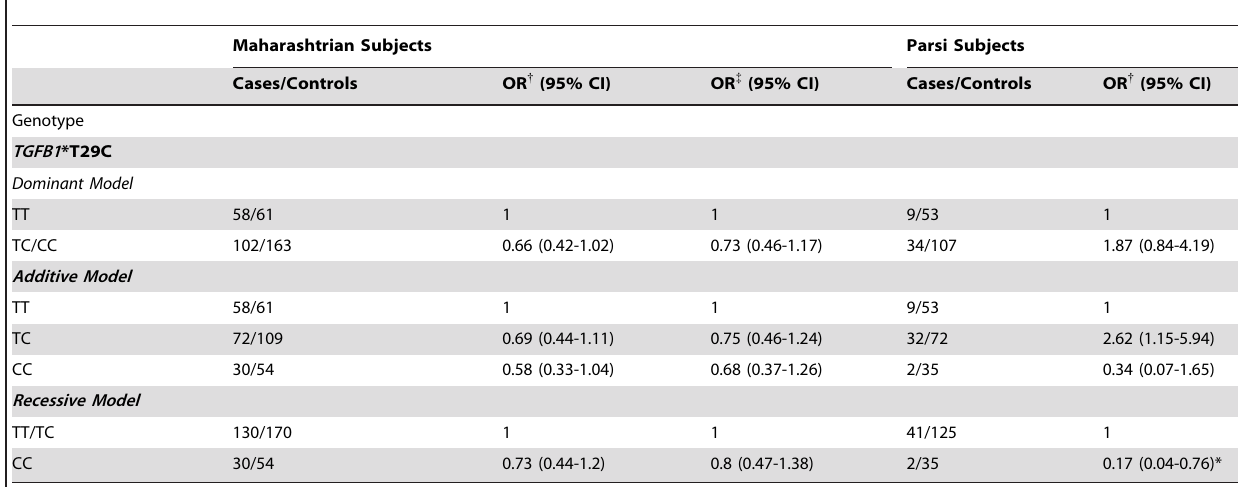
Table 3. TGFB1 T29C polymorphism and risk for breast cancer in Maharashtrian and Parsi women.